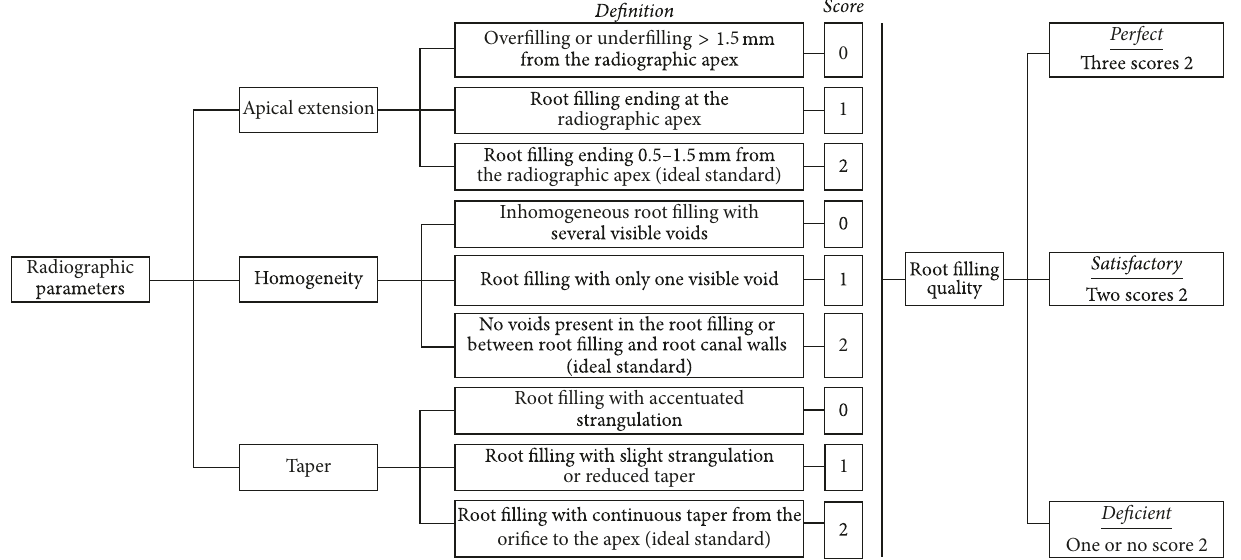
Figure 1: Drawing of the root filling quality standard as a function of radiographic parameters